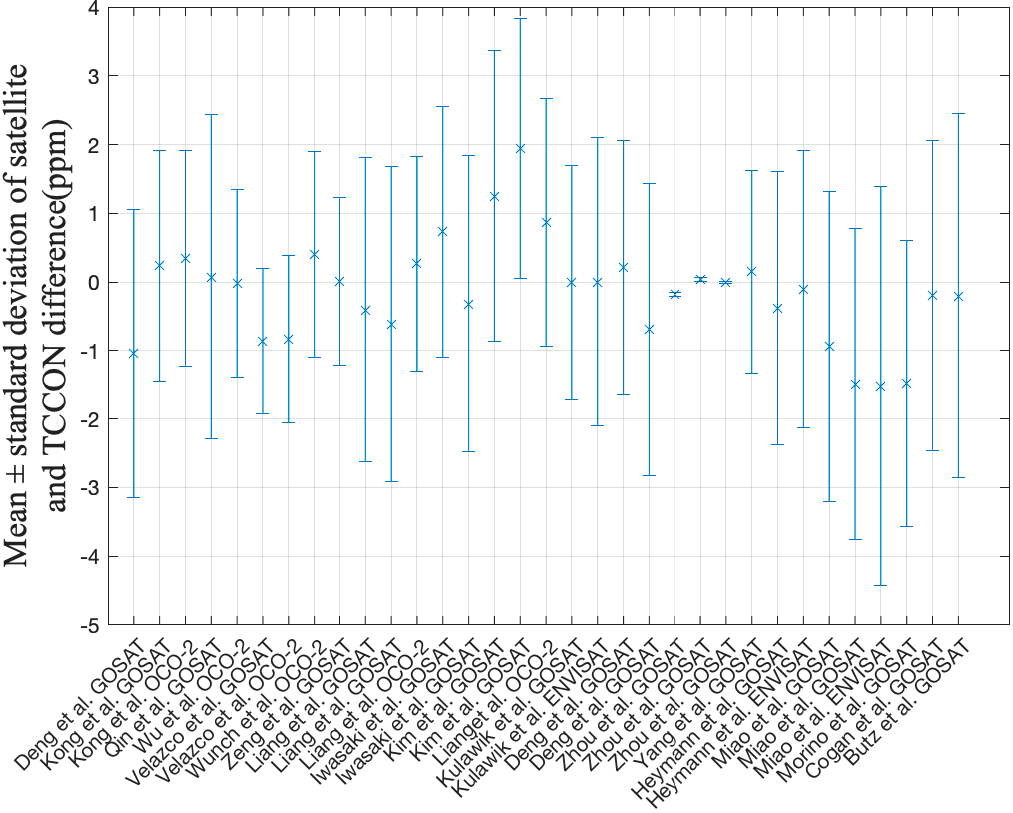
Figure A2. Comparison of satellite observations and TCCON stations (References detail are provided in the Table A4 in the Appendix A.). The different studies are labelled based on references.